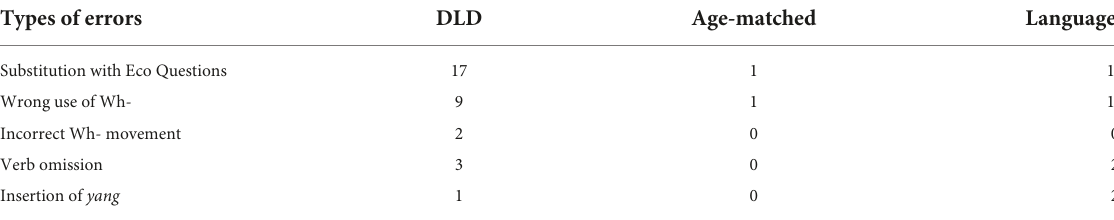
TABLE 8 Lexical errors across the structure of Wh- questions.